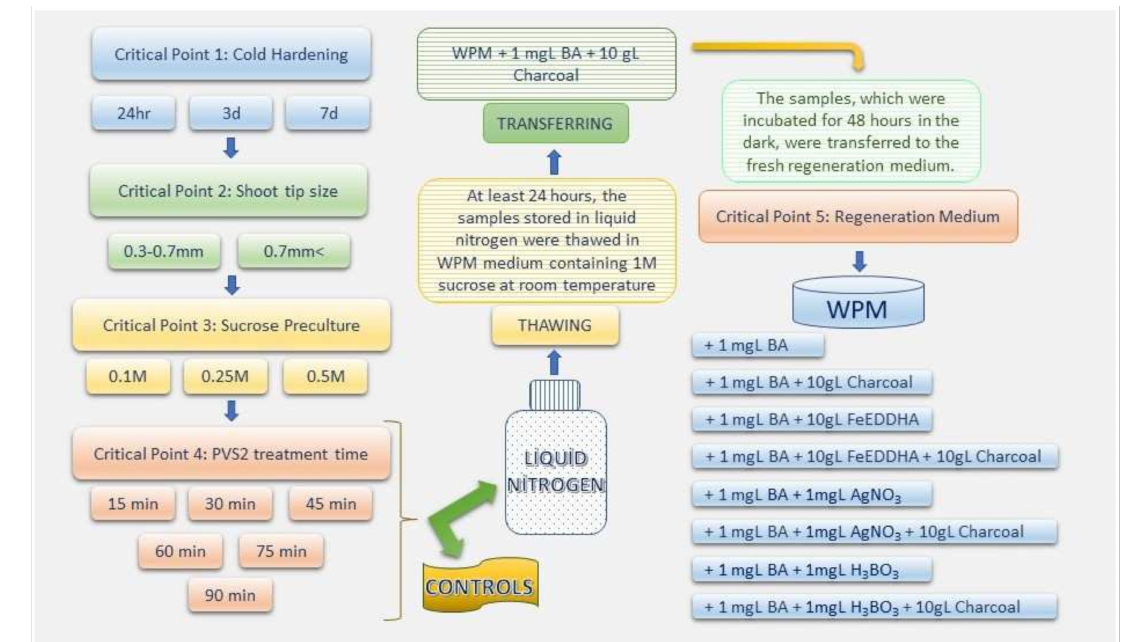
Figure 2. Schematic representation of the stages that are crucial for regeneration before and after cryopreservation of four different Citrus spp. cultivars via droplet